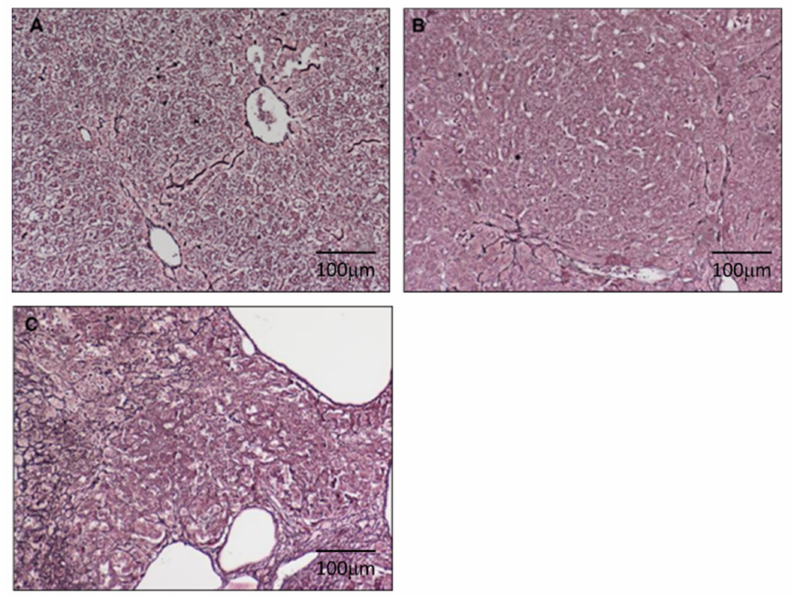
Figure 2. The reticulin staining in hamster liver: we applied a score ranging from 0 to 2 in week 7 ( n = 5), 27 ( n = 8), 33 ( n = 8), 50 ( n = 12) where a score of 0 indicated no regenerated/malignant cell ( A ); a score of 1 indicated the presence of liver regenerated nodules ( B ); and a score of 2 denoted definitive liver malignancy ( C